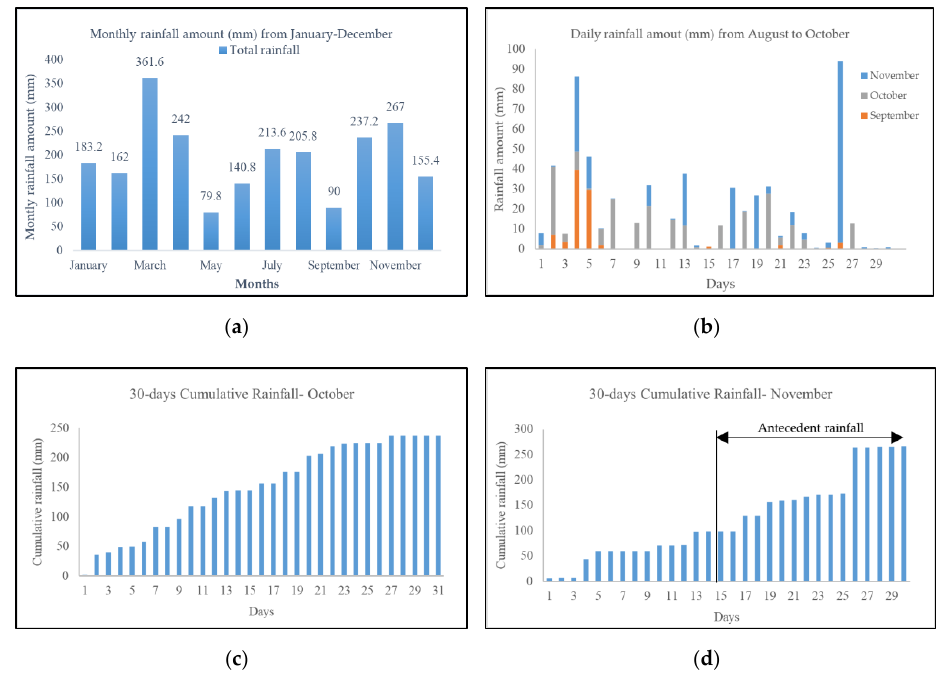
Figure 10. Rainfall distribution for Hulu Yam landslide: ( a ) overview rainfall distribution throughout the year; ( b ) daily rainfall distribution within three months (September–November); ( c ) 30 days of cumulative rainfall for October; ( d ) 30 days of cumulative rainfall for November.